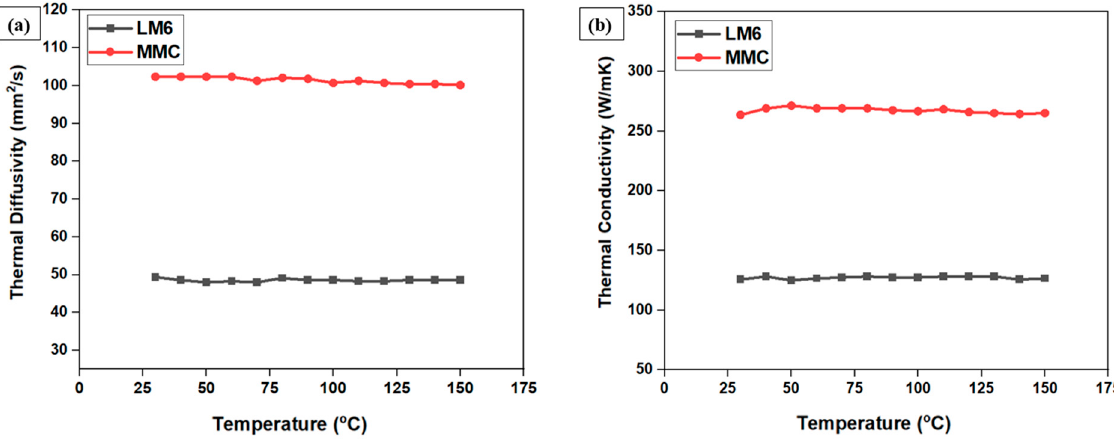
Figure 7. Comparative plots of ( a ) thermal diffusivity and ( b ) thermal conductivity of LM6 base alloy and fabricated MMC.